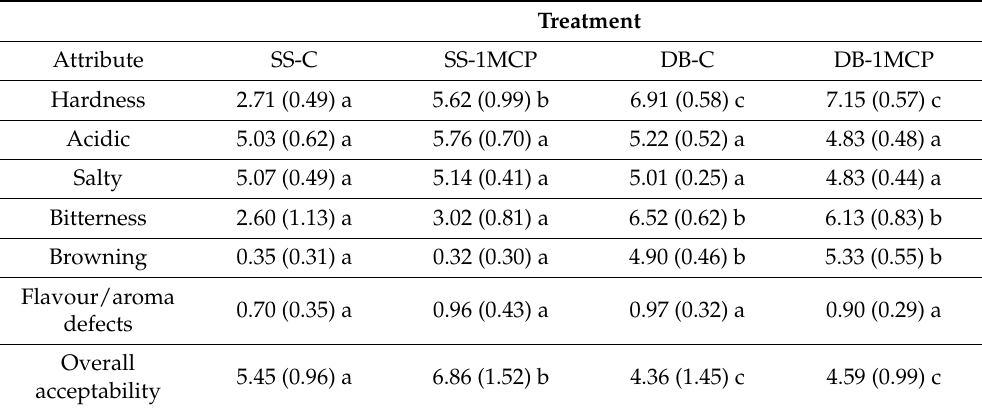
Table 2. Scores assigned by the 10 expert panellists to the sensory evaluation of the various treatments packaged in this